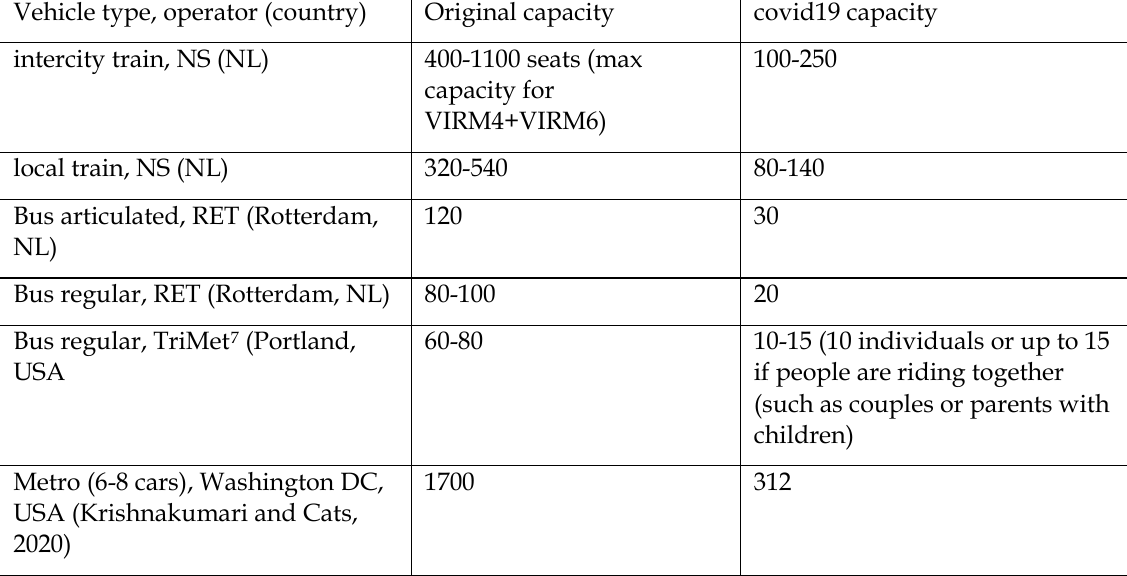
Table 1. Train capacity in some PT systems in normal and covid19 conditions Vehicle type, operator